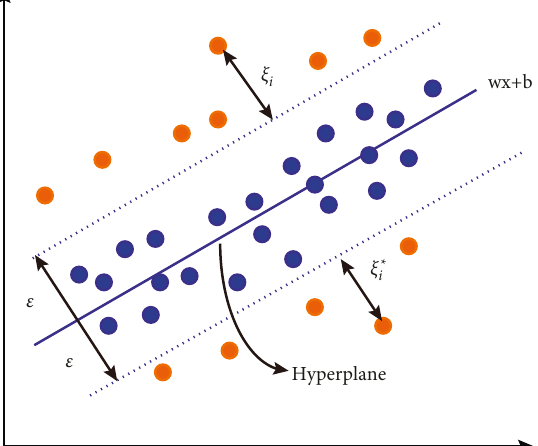
Figure 5: Regression of SVR.